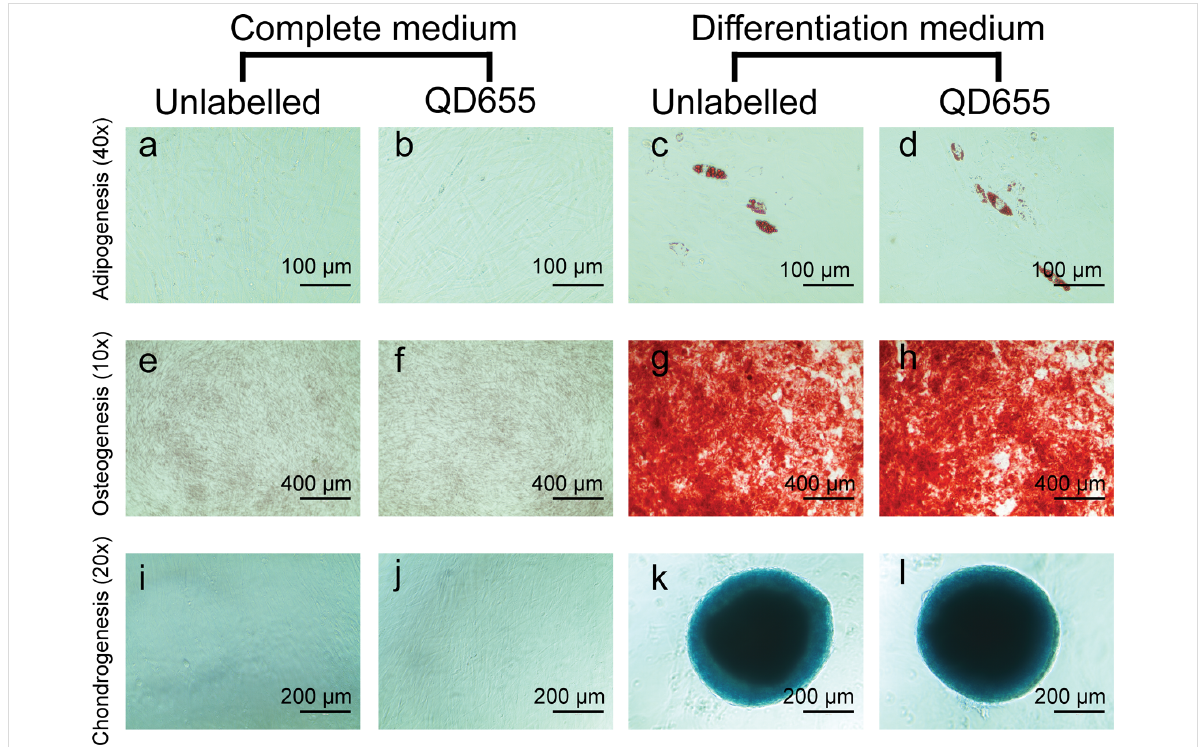
Figure 5: Differentiation of MSCs into adipocytes, chondrocytes and osteocytes. Oil Red O staining of cells in complete medium without (a) or with QD labelling (b); cells in adipogenesis medium without (c) or with QD labelling (d). Alizarin Red S staining on cells in complete medium in the absence or presence of QDs (e, f); cells in osteogenesis differentiation medium in the absence or presence of QDs (g, h). Alcian Blue staining on cells in com- plete medium (i, j) and chondrogenesis differentiation medium (k, l) in the absence or presence of QDs.